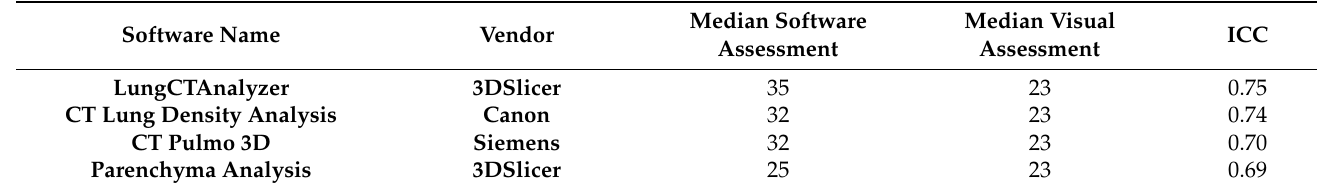
Table 4. Summary of the evaluations within the software and the visual assessments. This statistical calculation underlines that the best agreement was between 3DSlicer “LungCTAnalyzer” and the median of the visual score (ICC 0.75 with a CI 0.67–0.82 and with a median value of 22% of disease extension for the software and 25% for the visual values). The Canon software occupies second place, the Siemens software third place, and the 3DSlicer version “Parenchyma Analysis” last place. ICC = Intraclass Correlation Coefficient, CI = Confidence Interval.